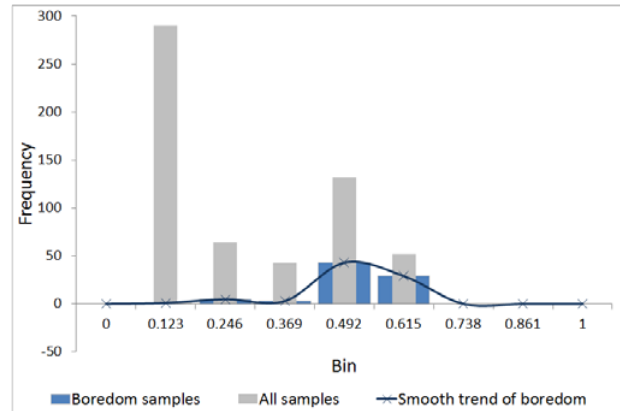
Figure 4. Histogram of boredom and all samples.